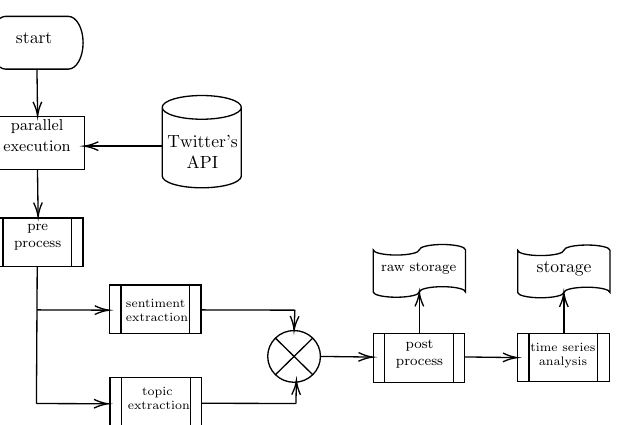
Figure 1. Data Flow Overview . We process the data in three main stages: first, we load the desired tweet IDs from the COVID-19 Twitter chatter dataset then consult them directly from Twitter using the official APIs. For pre-processing, we clean up and filter the data, and then we process this dataset to produce a time series of the perceived COVID-19-related